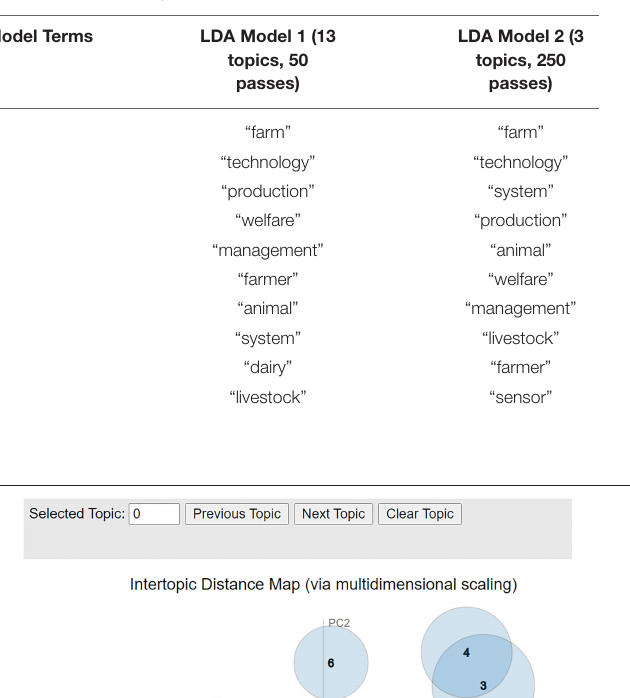
Models 1 and 2 is presented in Table 2 . For better segregation of